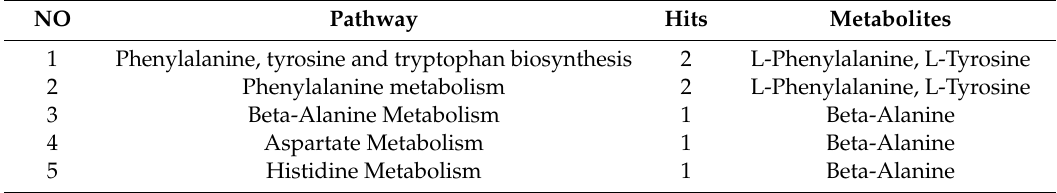
Table 5. Metabolic pathways and di ff erential